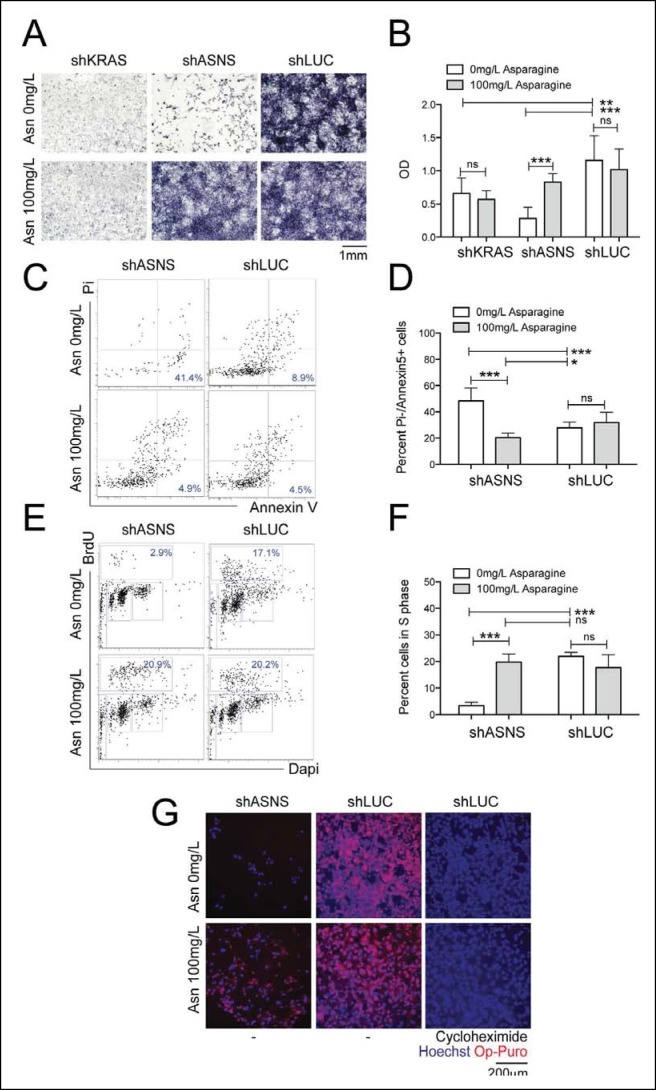
Reduced growth of mouse Kras;p16p19null RMS cells after Asns silencing is associated with inhibition of polypeptide synthesis.(A–B) ShRNA-mediated silencing of Asns and Kras in a mouse Kras;p16p19null RMS cell line reduced proliferation activity compared to shLUC-infected control cells as measured by MTT uptake. Asparagine supplementation (100 mg/L) in the tissue culture medium reversed the anti-proliferative effects of shASNS but not shKRAS. (C–F) Asns silencing increased the (C–D) percentage of apoptotoc (PI-/Annexin5+) cells and reduced the (E–F) percentage of S phase cells as determined by BrdU staining, compared to shLUC-infected control cells. Both effects were reversed by exogenous Asparagine supplementation (100 mg/L). (G) Polypeptide synthetic activity was determined by OP-puromycin staining. Absent OP-puromycin staining in cells treated with cycloheximide (right panels), an inhibitor of protein translation, validated the experimental approach. Asns silencing reduced polypeptide synthesis in Kras;p16p19null RMS cells (top left panel), and polypeptide synthesis was restored in shASNS RMS cells by Asparagine supplementation (bottom left panel). (A–F) Data were evaluated for statistical significance by T-tests (ns p≥0.05, *p<0.05, **p<0.01, ***p <0.001). See Figure 2—figure supplement 1 for similar effects of Asns silencing in mouse Kras;p16p19null NMS cells.